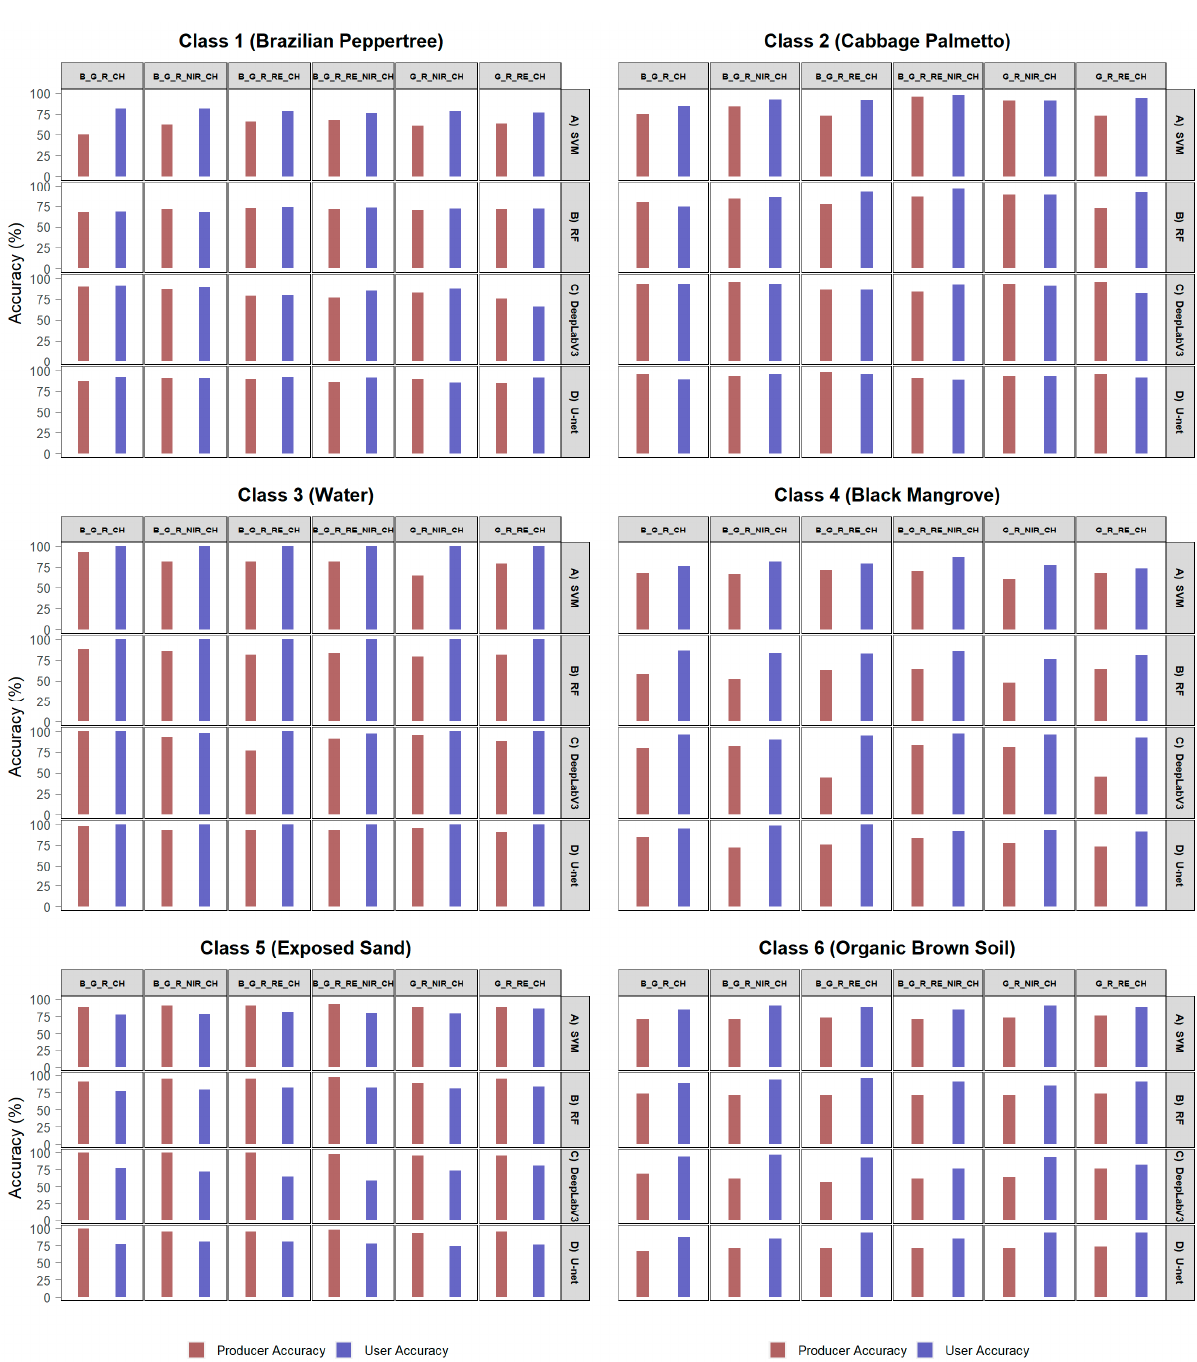
Figure A7. Experiment: EXP3-SB_ UAS_CHM, producer and user accuracy organized by class and classification method., classes 1 to 6.